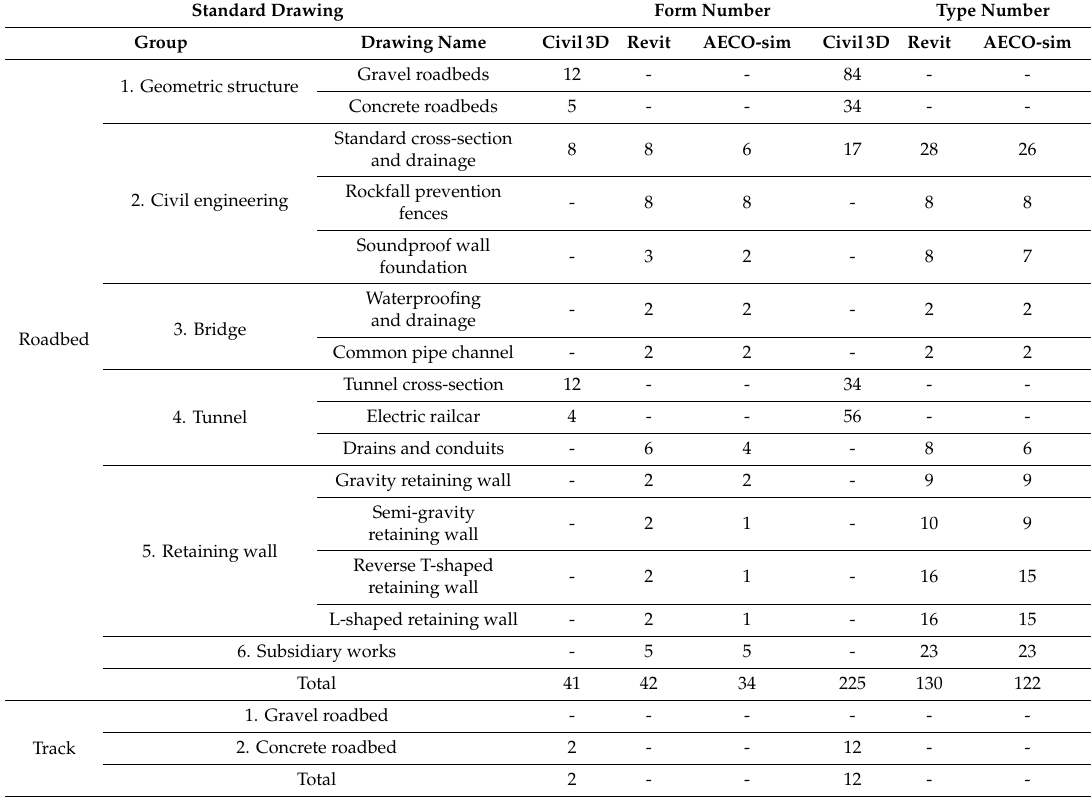
Table 7. Developed building information modeling (BIM)